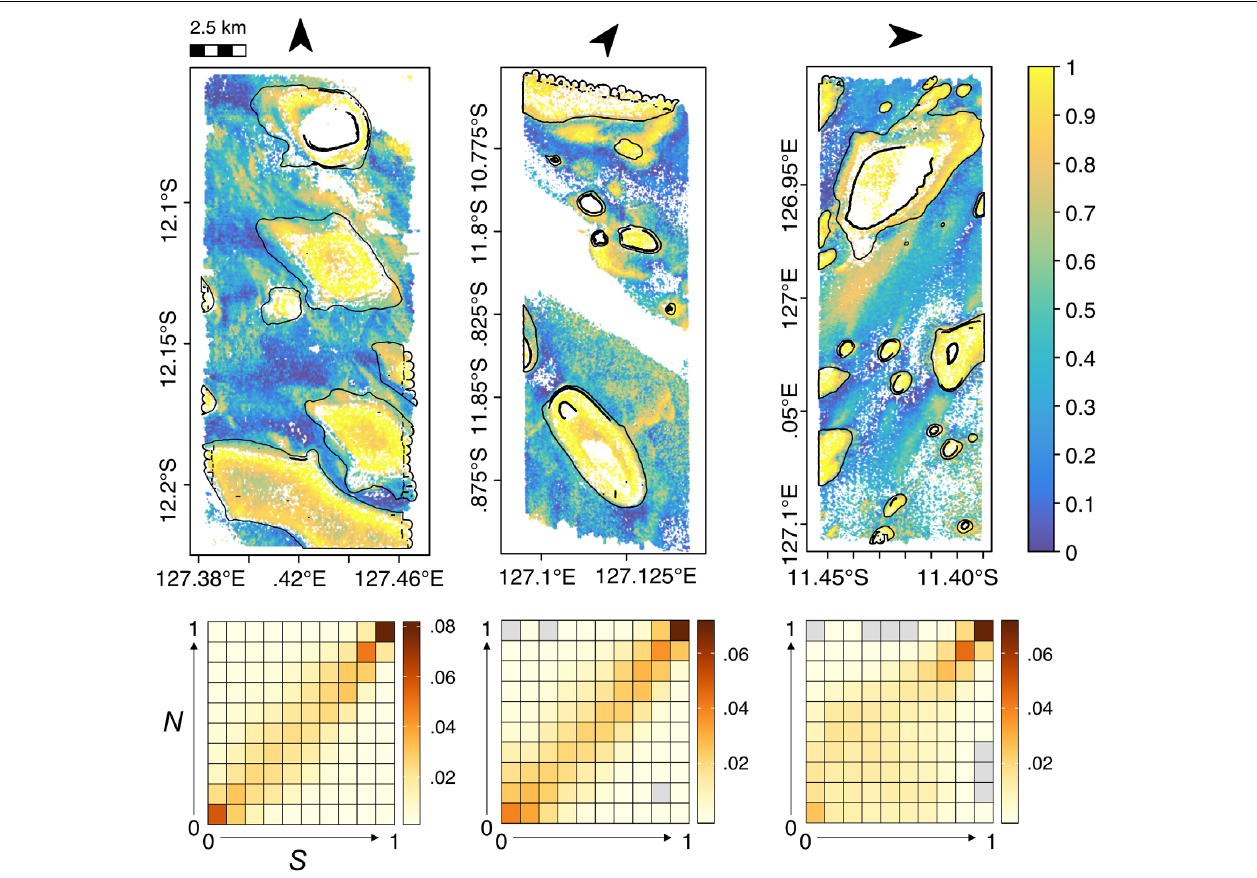
FIGURE 5 | Maps of pelagic “hotspots” within sub-areas of the Oceanic Shoals Australian Marine Park (AMP), as predicted from the best GAMM models. Top: Median additive decile ranks (normalized to 0–1) calculated from predictions of species richness ( S ) and abundance ( N ) in each sampling site (1 to 3 from left to right). Yellow tones represent areas where both S and N are high (i.e., hotspots), whereas blue tones denote areas where both S and N are low (cold spots). Areas outside the covariate range of environmental predictors are left white (see main text for details). Bottom: Bivariate partitioning of S and N used in deriving the hotspot index. Gray cells denote combinations that were not observed in the data. The outlines of carbonate banks are superimposed as solid black lines. Arrows indicate the direction of compass north.